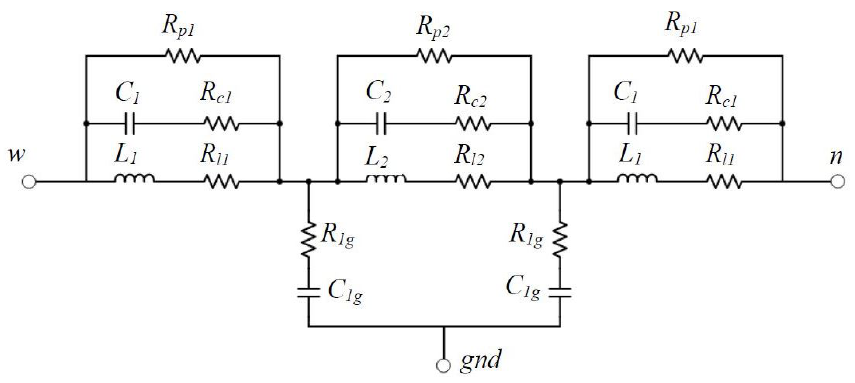
Figure 17. HF phase circuit proposed in [80].